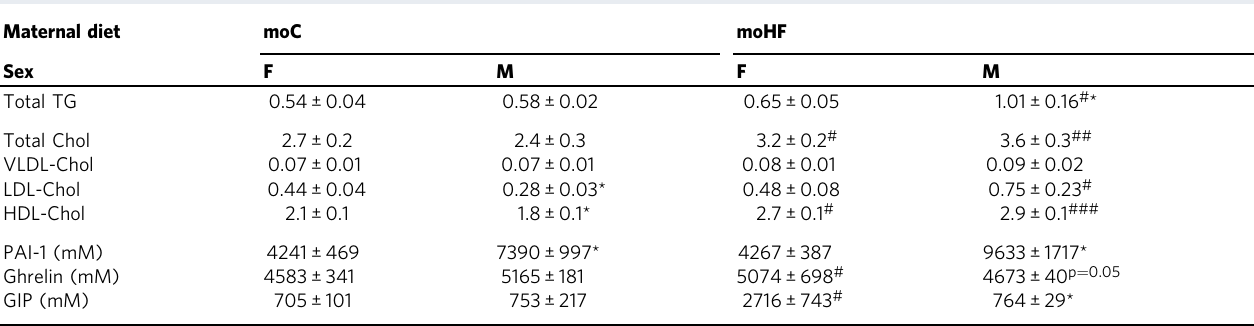
Animals were fasted for 2h prior the blood collection. Data are presented as mean±sem. F: female; M: male; *, M versus F and # , moC versus moHF. * or # , P <0.05; ## , P <0.01; ### , P <0.001. For F- moC, n = 5; for M-moC, n = 6; for F-moHF, n = 6; for M-moHF, n =